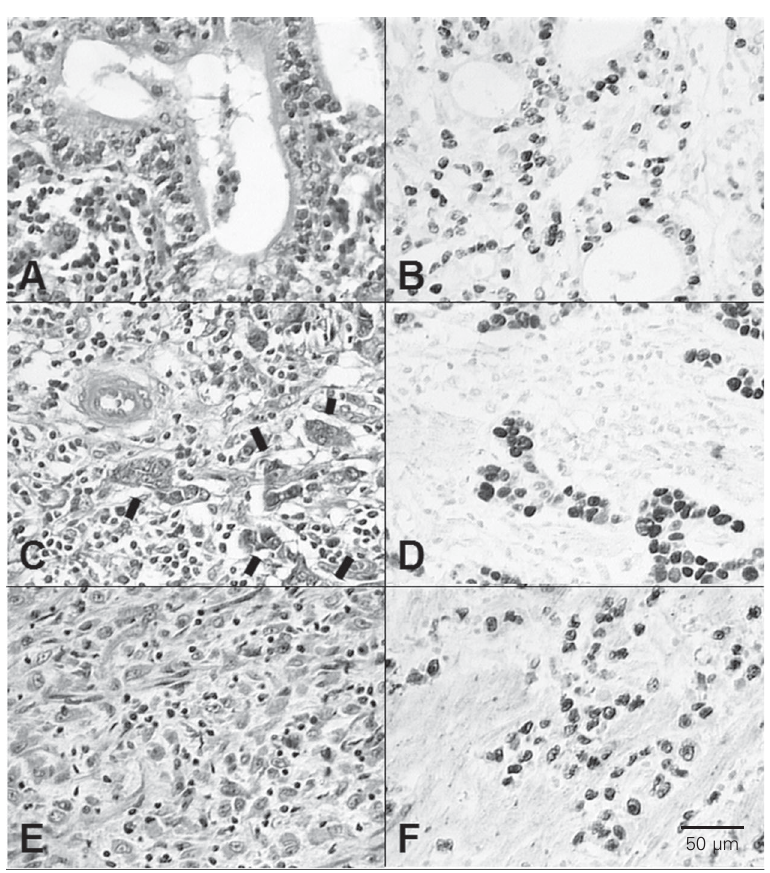
Figure 1. Photomicrographs of the Epstein-Barr virus-positive carcinomas. A , Tubular adenocarcinoma (hematoxylin and eosin, 400X). B , Tubular adenocarcinoma showing nuclear EBER-I signals (EBER-I, 400X). C , Lymphoepithelioma-like carcinoma (hematoxylin and eosin, 400X). D , Lymphoepithelioma-like carcinoma showing nuclear EBER-I signals (EBER-I, 400X). E , Undifferentiated carcinoma (hematoxylin and eosin, 400X). F , Undiffer- entiated carcinoma showing nuclear EBER-I signals (EBER-I,